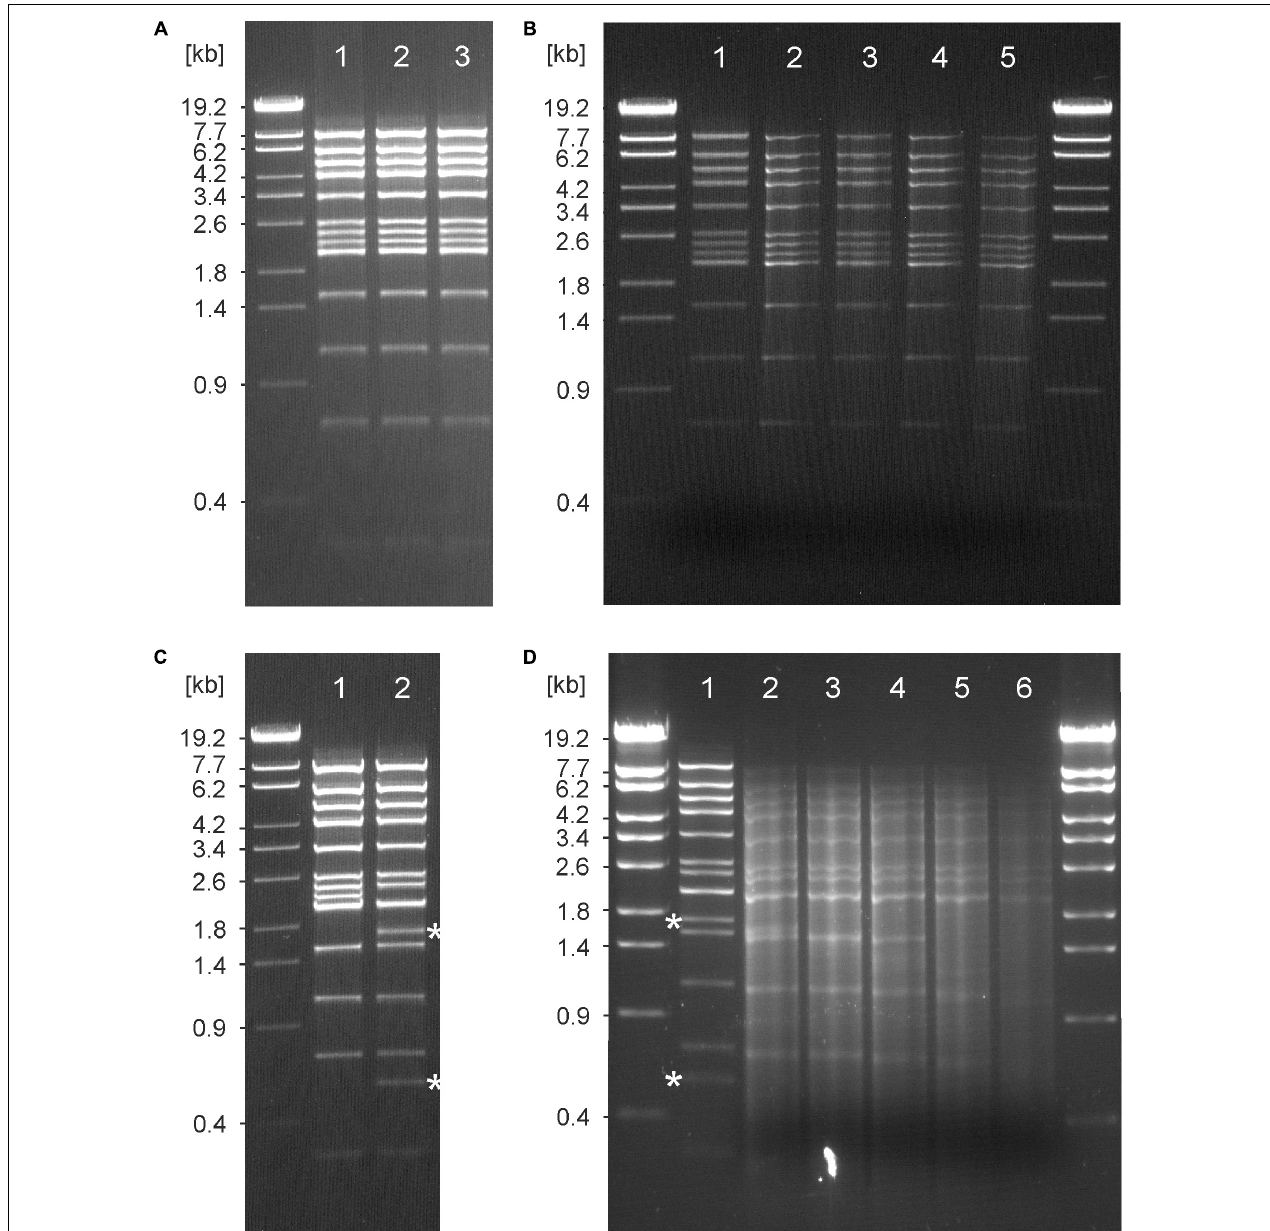
FIGURE 6 | Analysis of the (cid:56) E067 genome ends. (A) EcoRI digests of the phage DNA. Lane 1, untreated digest, lane 2, restriction pattern after heating of the digest at 80 ◦ C for 10 min and subsequent cooling on ice, lane 3, DNA that had been treated with T4 ligase before restriction. (B) Bal31 analysis. Lane 1, EcoRI digest without Bal31 (control), lane 2, (cid:56) E067 DNA that had been treated with Bal31 (0.1 units) for 15 min before digestion with EcoRI, lane 3, same as before, but 30 min, lane 4, same as before, but 60 min, lane 5, same as before, but 120 min. (C) Comparison of the EcoRI single digest with the EcoRI/HindIII double digest. Lane 1, EcoRI restriction pattern, lane 2, EcoRI/HindIII restriction pattern; the two bands of 1,771 bp and 569 bp generated by HindIII are indicated. (D) Bal31 analysis of (cid:56) E067 DNA that had afore been cleaved by HindIII. Lane 1, EcoRI/HindIII digest without Bal31, lane 2, (cid:56) E067 DNA that had been treated with Bal31 (0.1 units) for 5 min before digestion with EcoRI, lane 3, same as before, but 15 min, lane 4, same as before, but 30 min, lane 5, same as before, but 60 min, lane 6, same as before, and but 120 min. The two bands of 1,771 bp and 569 bp generated by HindIII, but no other bands of the digest disappeared after 5 to 15 min of incubation with